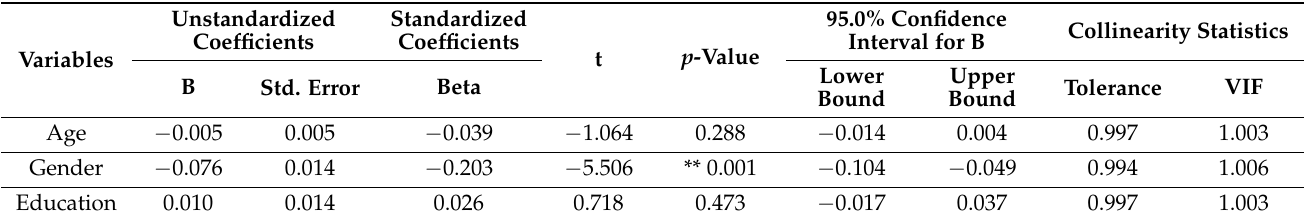
Table 3. Comparison of patient’s satisfaction (PS) with demographic characteristics (n =